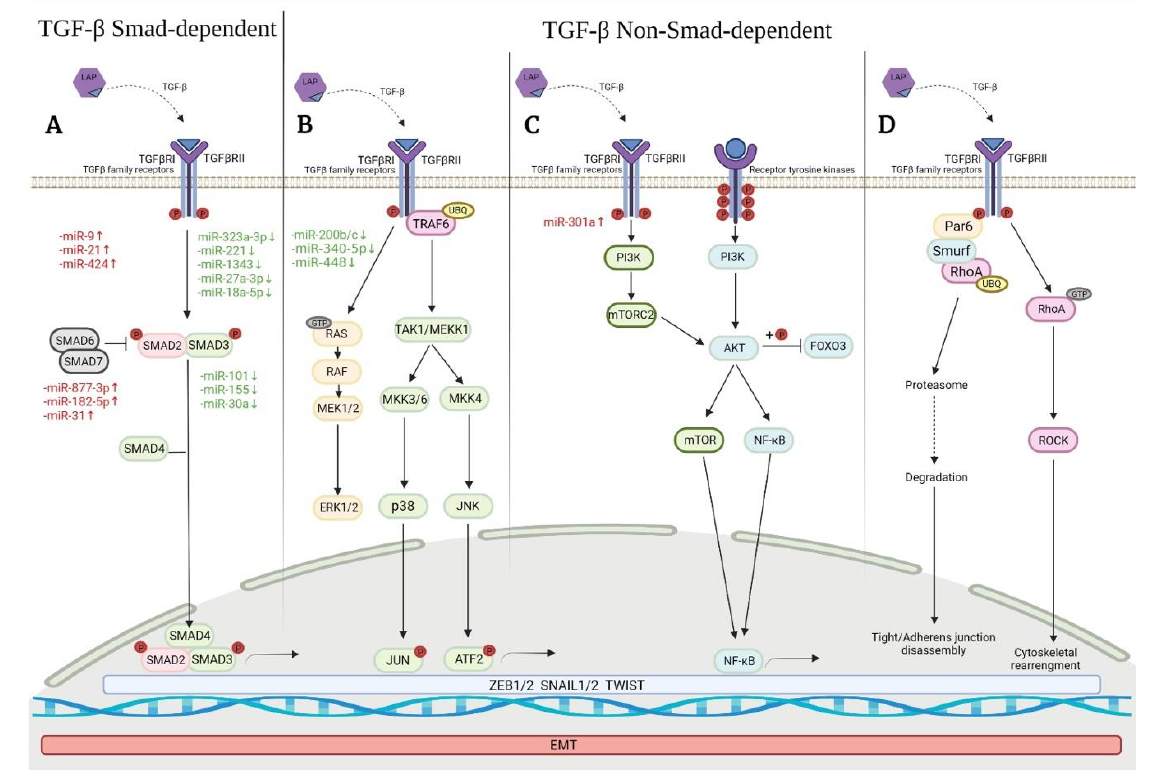
Figure 1. Signaling pathways related to the activation of TGFβ -induced Epithelial Mesenchymal Transition (EMT) in Idiopathic Pulmonary Fibrosis (IPF), and examples of some associated miRNAs. ( A ) Smad signaling TGFβ -induced activates transcription factors that promotes the EMT; ( B ) Non- Smad signaling TGFβ -induced includes the activation of Erk1/2, p38 and JNK MAPK kinases path- ways; ( C ) Non- Smad signaling TGFβ -induced activates a receptor with tyrosine kinases activity, which activates both P13K/Akt/mTOR and NF- kβ pathways; ( D ) Non- Smad signaling TGFβ -in- duced activates ubiquitin-mediated RhoA degradation at tight/adherens junctions or Rho kinase activity during the assembly of actin stress fibers in the TGFβ -induced EMT. Red color indicates up- regulated miRNAs, and green color indicates downregulated miRNAs.